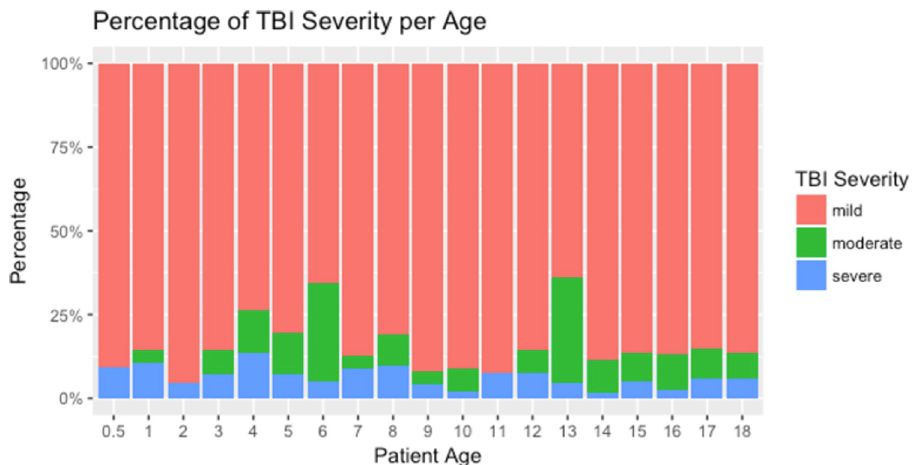
Fig 2. Pediatric patients by age and injury severity. The percentage of mild, moderate, and severe traumatic brain injury for pediatric patients at each age.